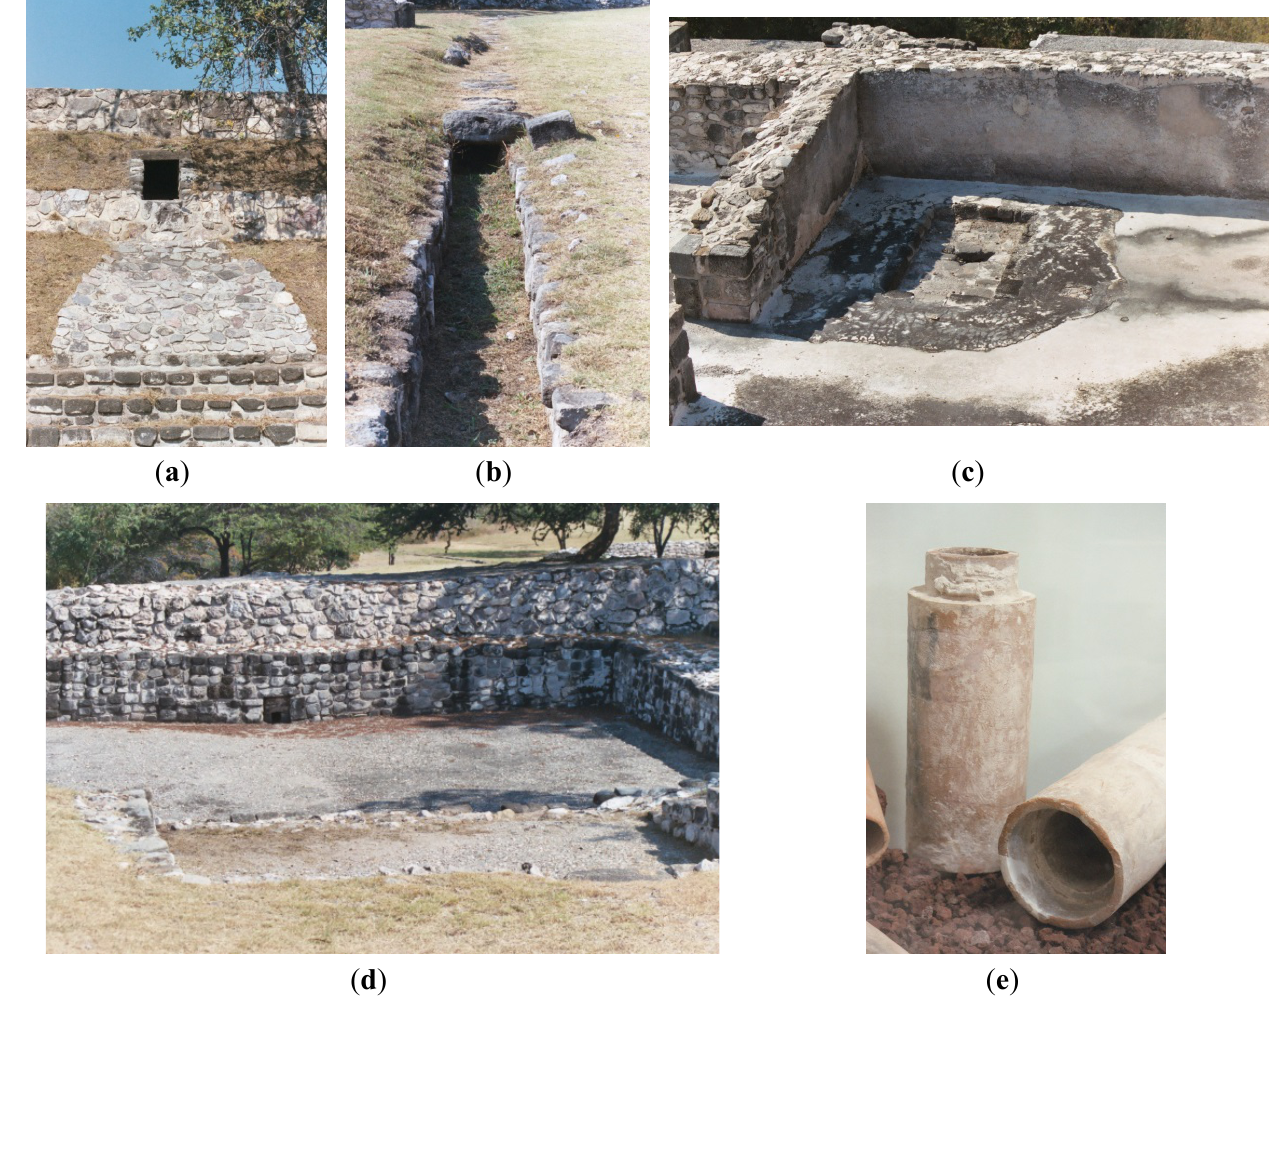
Figure 20. Components of Xochicalco rainwater harvesting system: ( a ) drainage structure; ( b ) drainage channel; ( c ) cistern; ( d ) cistern; ( e ) terracota pipes. (photos copyright by L.W.